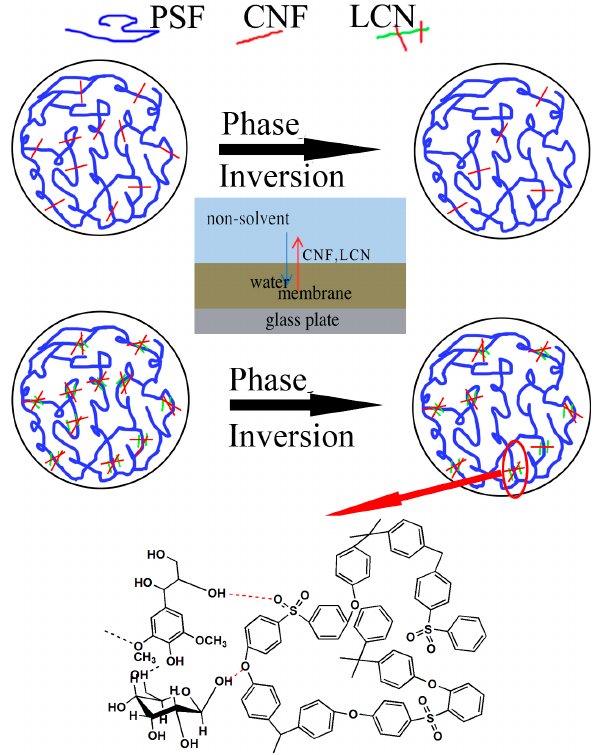
Figure 2. The possible membrane formation mechanism affected by the cellulose nanofibrils (CNF) and Lignocellulose nanofibrils (LCN).